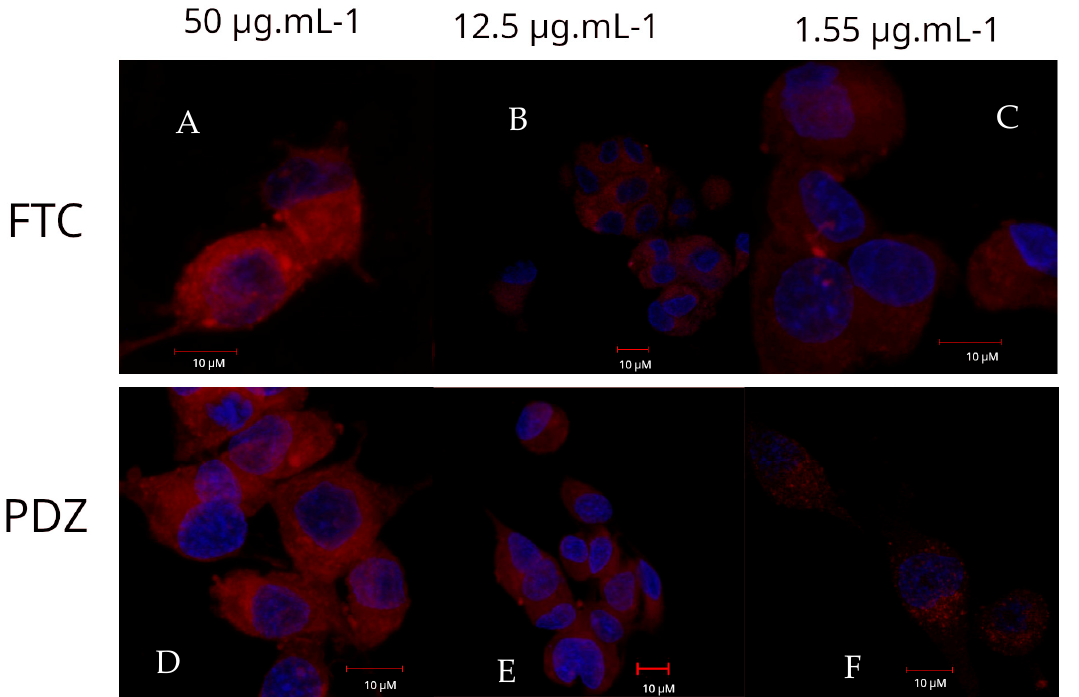
Figure 2. Internalization of PS in 9 L/lacZ cells by fluorescence confocal microscopy. ( A )—50 µg mL − 1 FTC; ( B )—µg mL − 1 FTC; ( C )—1.55 µg mL − 1 FTC; ( D )—50 µg mL − 1 PDZ; ( E )—µg mL − 1 PDZ; ( F )—1.55 µg mL − 1 PDZ. The DAPI labeling is observed in blue, attributed to the DNA, and the fluorescence of FTC and PDZ in red, in the cytoplasm.